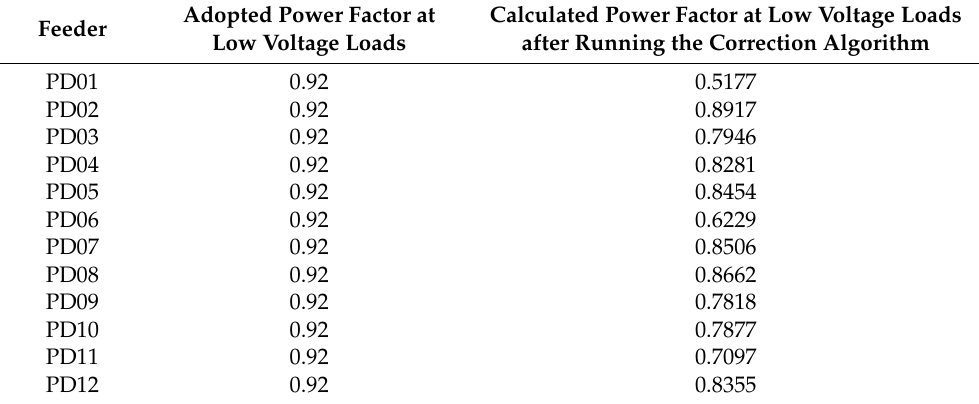
Table 5. Power factor correction algorithm applied at low voltage loads of the feeders. Adopted Power Factor Feeder